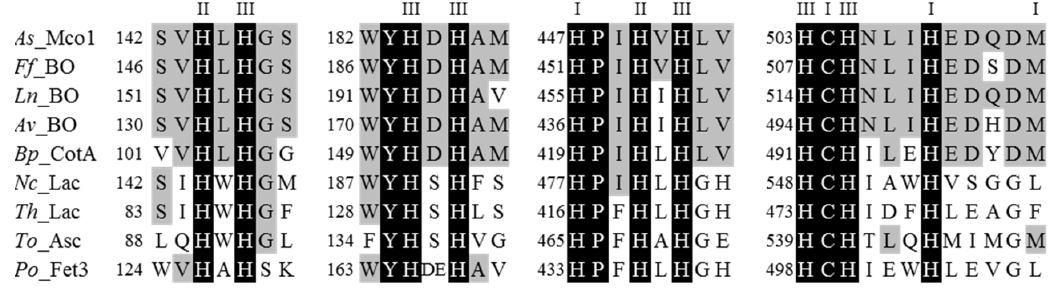
Figure 2. Amino acid sequence alignment of the four conserved Cu-binding regions in A. strictum KR21-2 ( As ) Mco1 and related MCO proteins including fungal bilirubin oxidases (BO), laccases (Lac), L-ascorbate oxidase (Asc), Fet3 ferroxidase, and bacterial CotA protein. Ff , Fusarium floridanum ; Ln , Lophiotrema nucula ; Av , Albifimbria verrucaria ; Bp , Bacillus pumilus ; Nc , Neurospora crassa ; Th , Trametes hirsuta ; To , Tolypocladium ophioglossoides ; Po , Pleurotus ostreatus . The Cu-binding T1, T2, and T3 residues are represented by I, II, and III, respectively. For accession number of each sequence, see Figure S2. In fungal proteins, the positions of amino acid residues were counted for the polypeptide accompanied by N-terminal signal sequence.